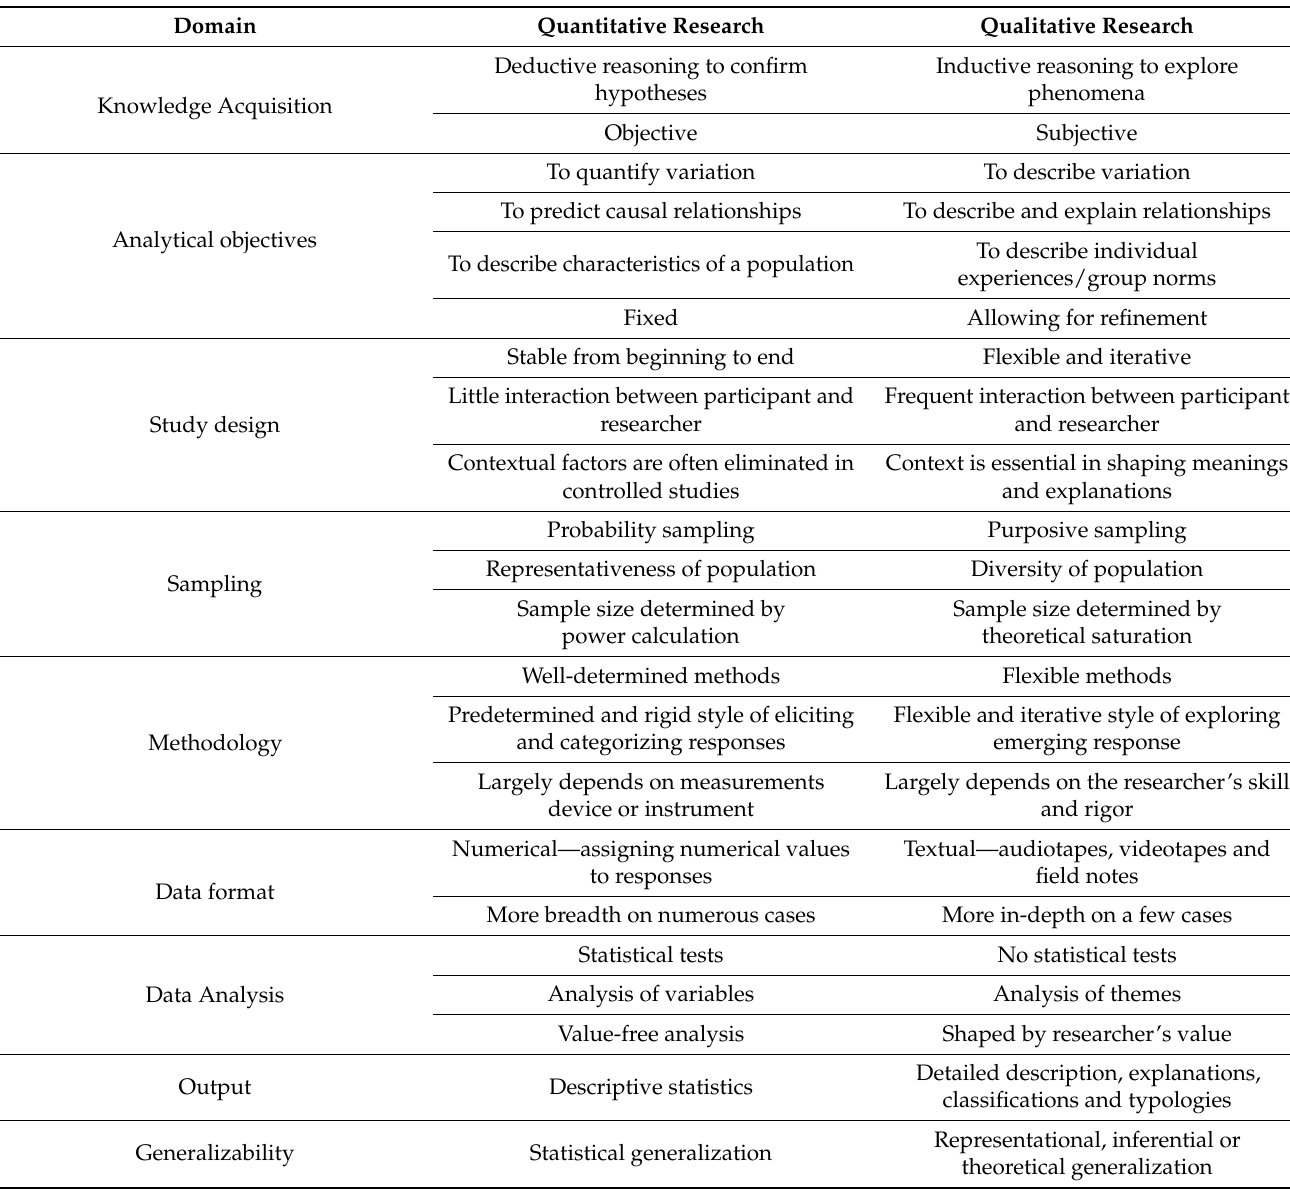
Table 1. Domains of quantitative research and qualitative research (Adapted from Ritchie et al., 2003; Masood et al., 2010; Bower et al., 2007